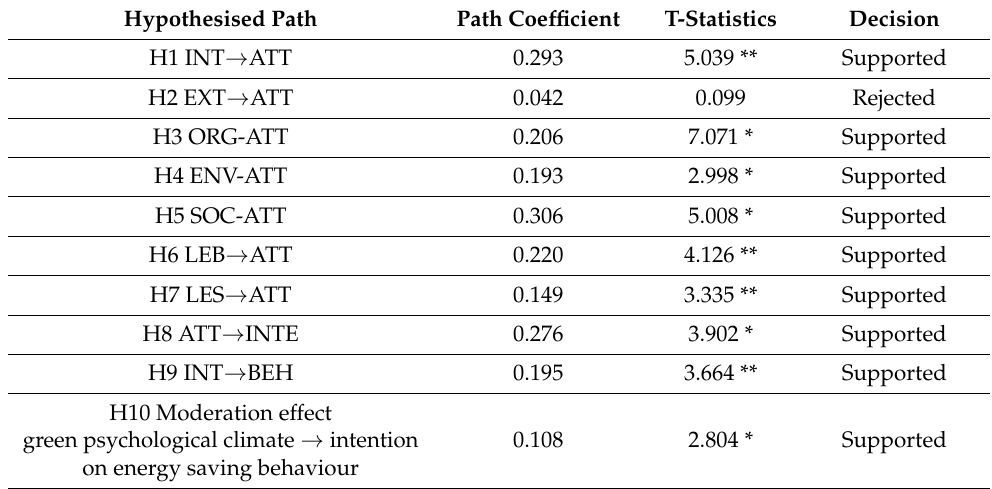
Table 3. Path coefficient and